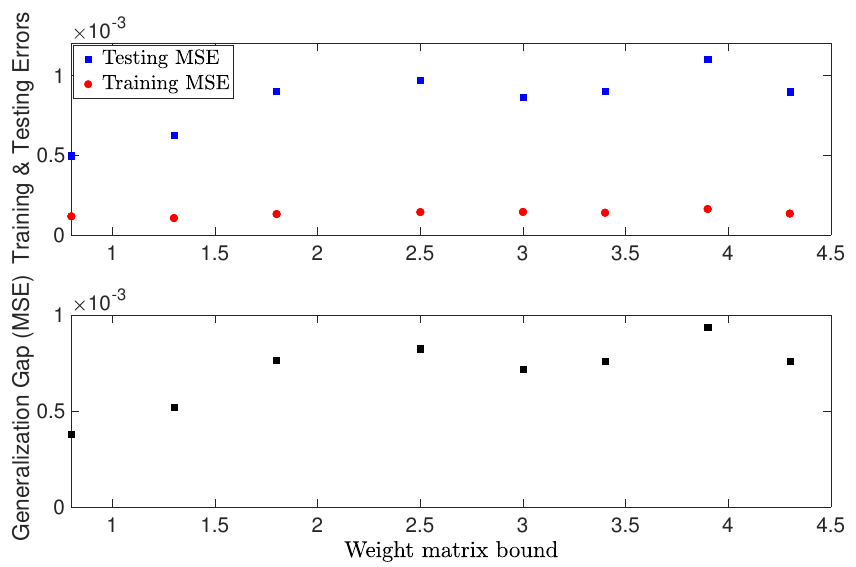
Figure 7. RNN generalization performance vs. weight matrix